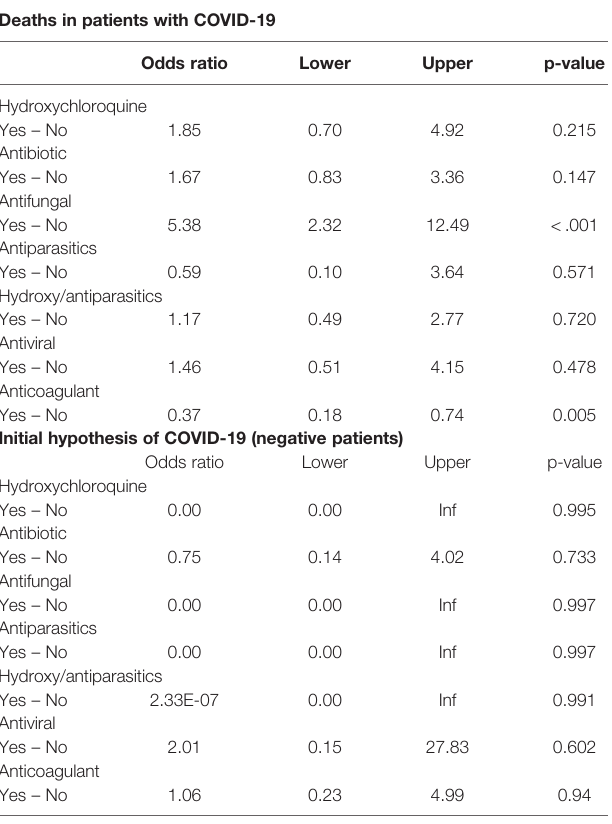
TABLE 5 | Binomial logistic regression model to verify the association of variables: use of hydroxychloroquine, antibiotic, antifungal, antiparasitic, antiviral, or heparin, in the deaths of hospitalized patients with a suspected COVID-19 diagnosis. Deaths in patients with